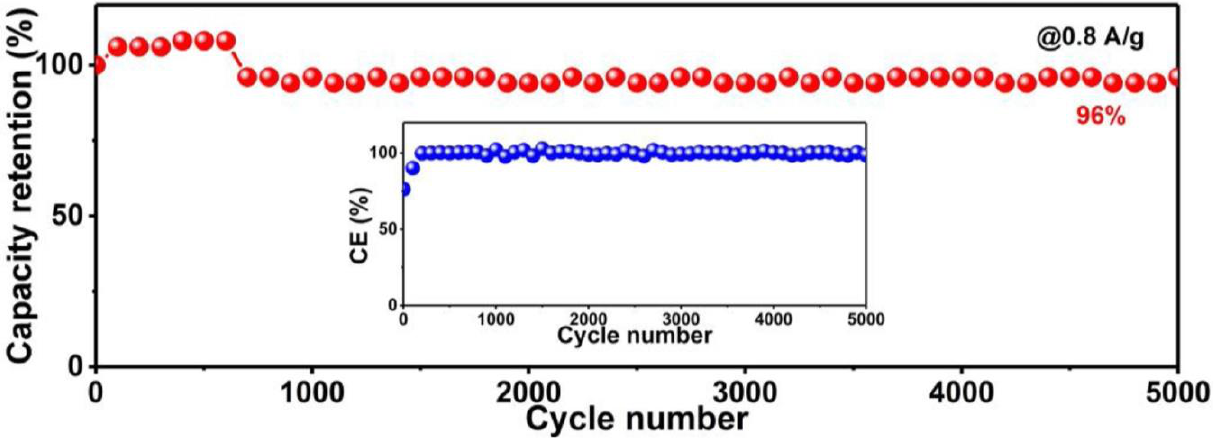
Figure 7. Cycling performance of the HSC device tested at 0.8 A/g over 5000 cycles. Red balls represent capacity retention, while the blue balls in the inset represent Columbic efficiency [67]. Copyright 2021 Elsevier.